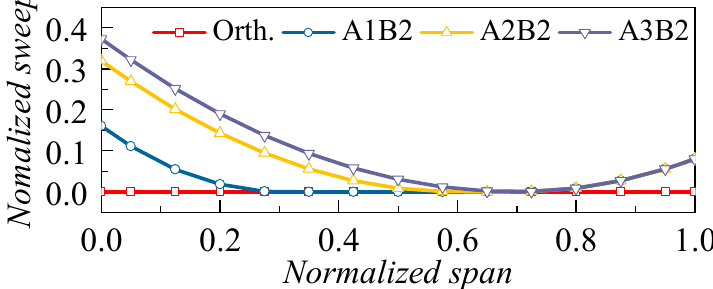
Figure 4. Radial distribution of blade sweep for the cases with different sweep heights. The pressure rise and loss characteristics of the cantilevered stators are demonstrated in Figure 5. Results show that, except for the near-stall condition of A1B2, the utilization of the forward sweep could always improve the stator aerodynamic performance in comparison to the baseline case. Moreover, the comparison of different schemes indicates that the 60% sweep height (A2B2) outperforms the other designs. At the near-stall condition, the static pressure rise coefficient and the total pressure loss coefficient in A2B2 are increased and decreased by 14.3% and 5.4%,